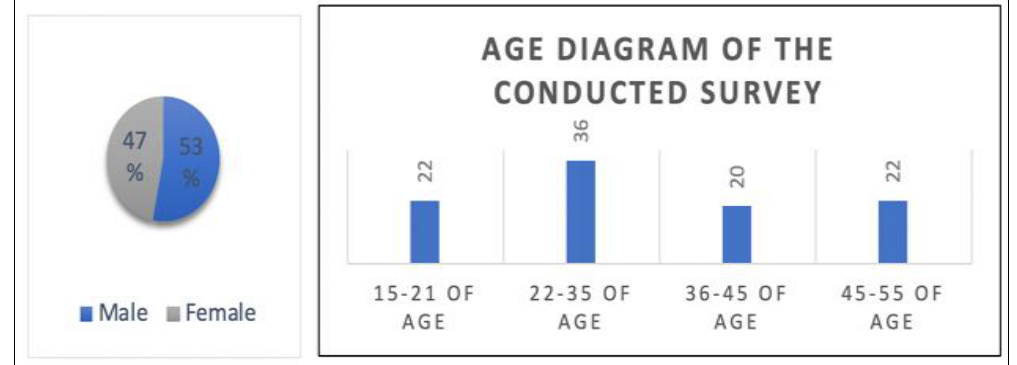
Figure 2. The gender and age diagram of the people who participated in survey.